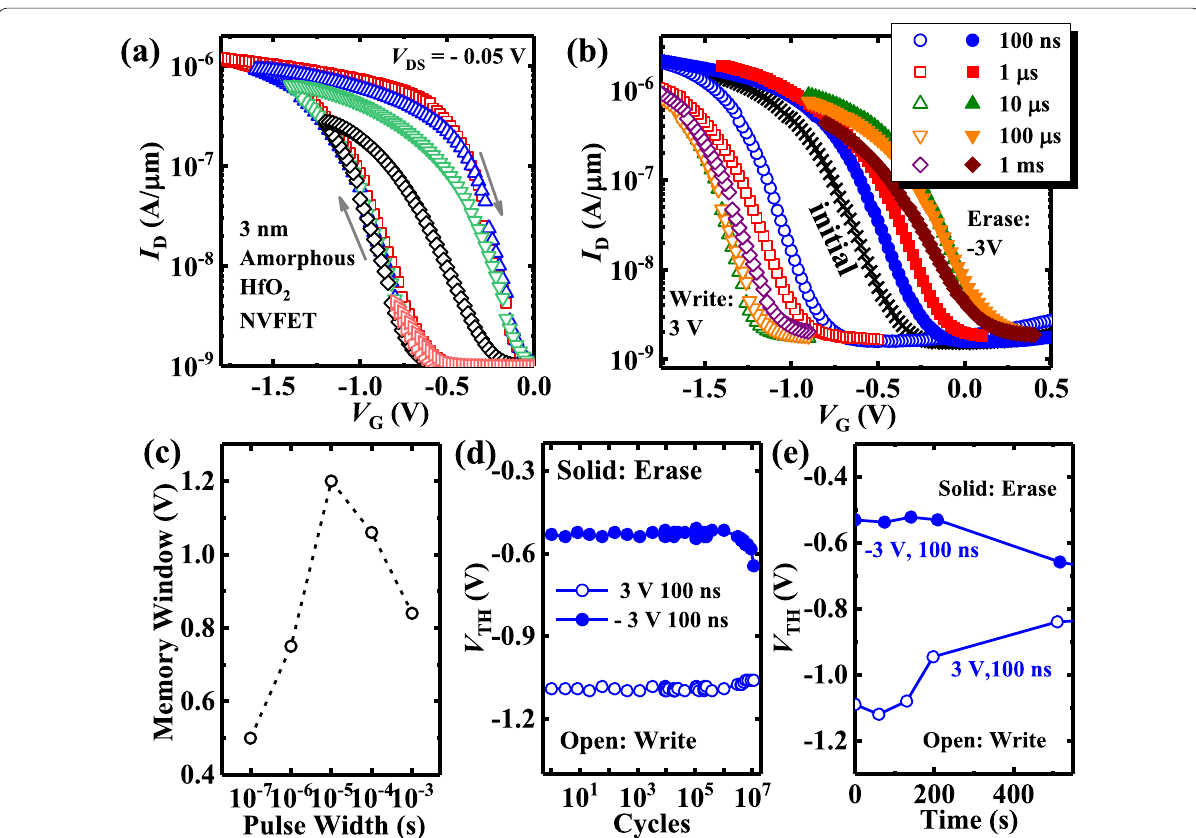
Fig. 2 a Dual-direction sweeping of I D - V G curves of the amorphous HfO 2 NVFET. b Measured I D - V G curves of the device with the pulse width varies from 100 ns to 1 ms. c MW for the amorphous HfO 2 NVFET with various pulse width. d Stable MW maintains after 10 6 W/E cycles underwent 3 V, 100 ns W/E pulses. e Several hundred seconds retention time was maintained of the amorphous HfO 2 ±